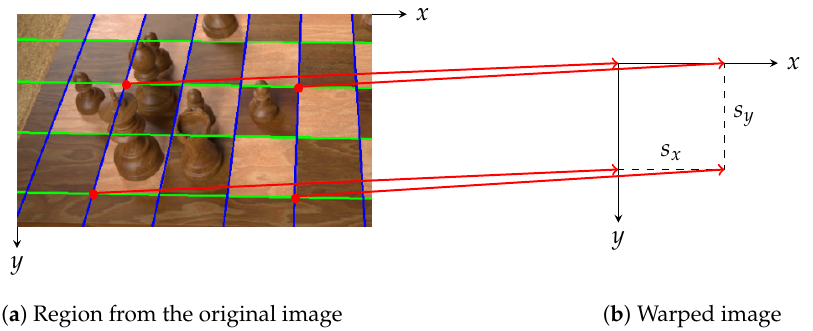
Figure 3. Four intersection points are projected onto the warped grid. The optimal values for the scale factors s x and s y are chosen based on how many other points would be explained by that choice, in order to determine the actual number of horizontal and vertical chess squares in the rectangular region from the original image. In this example, the algorithm finds s x = 3 and s y = 2.